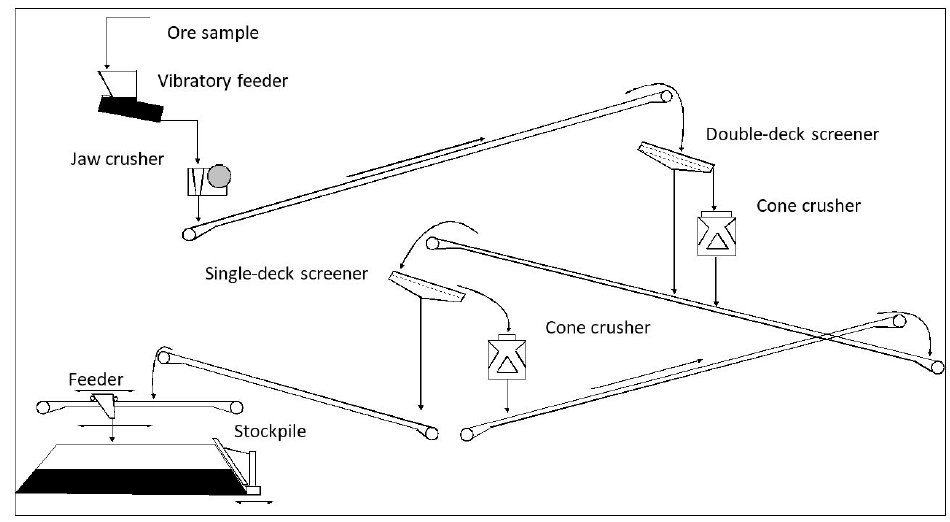
Figure 9. Three-phase fine crushing at GTK Mintec.